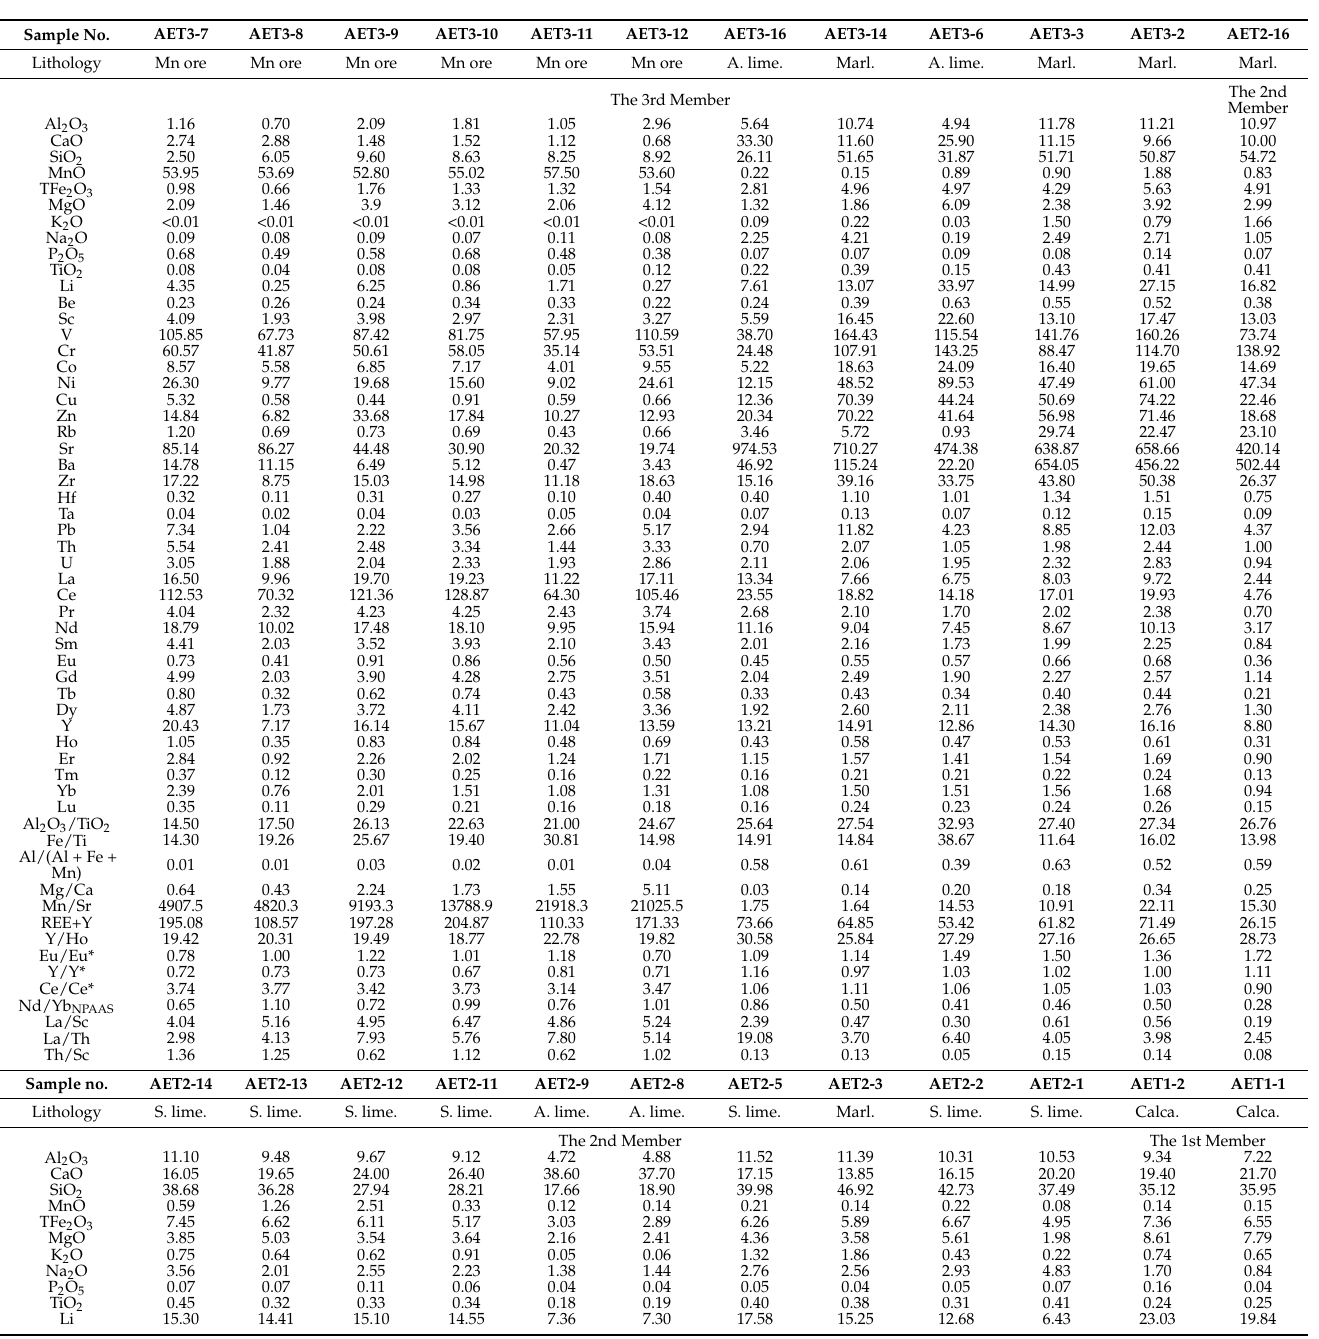
Table 1. Compiled major (wt%) and trace element (ppm) concentrations for samples of the Upper Carboniferous Kalaatehe